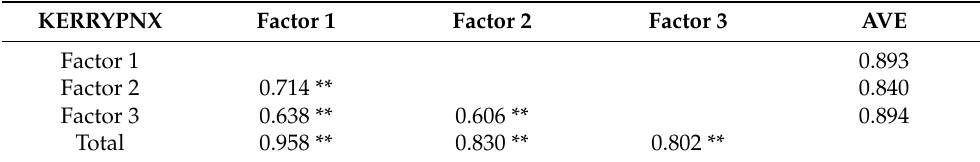
Table 4. Discriminant validity.